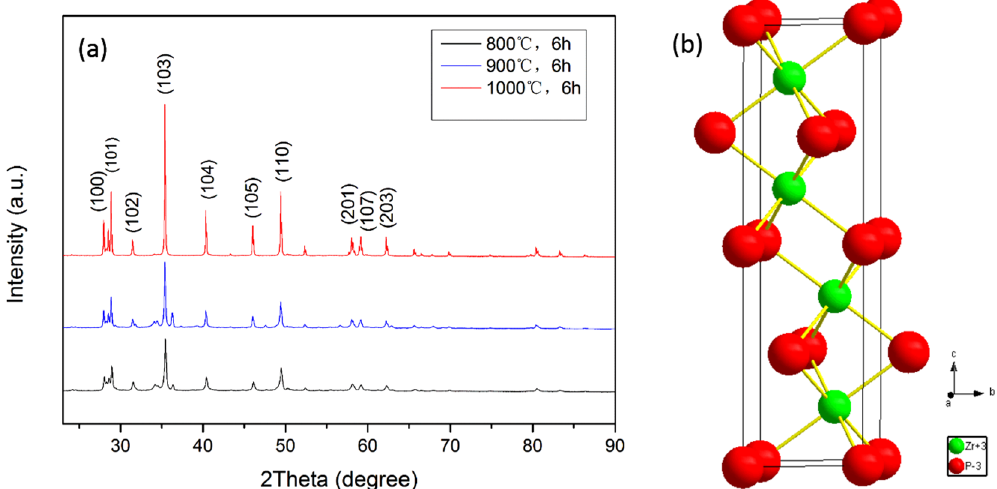
Figure 1. XRD patterns and Crystal structure of the ZrP samples. ( a ) XRD patterns of the ZrP prepared at different temperatures ( b ) Crystal structure of ZrP. The red and green balls represent phosphorus and zirconium atoms,